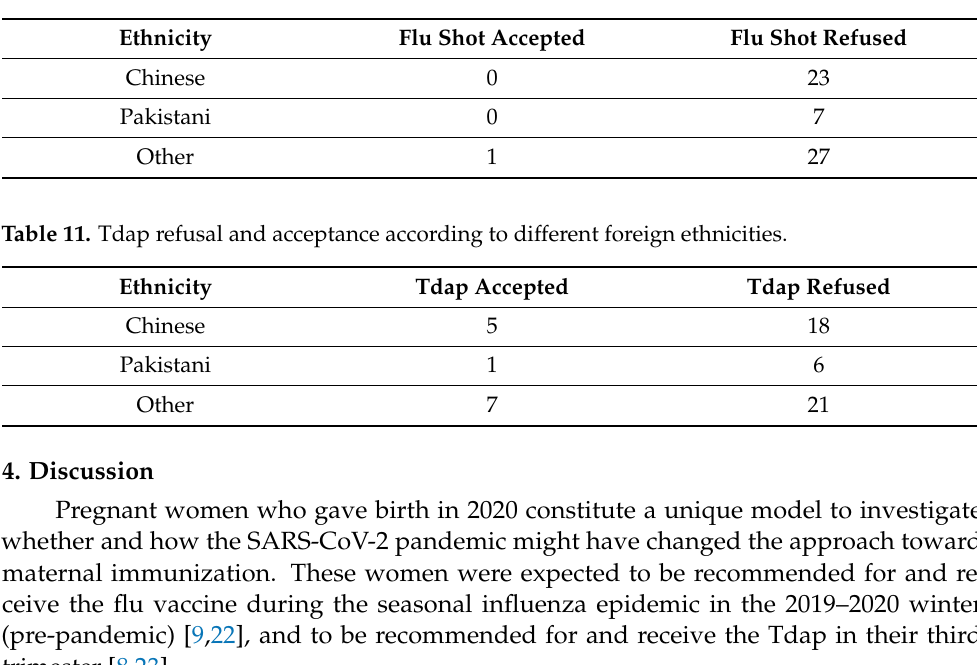
Table 10. Flu refusal and acceptance according to different foreign ethnicities.